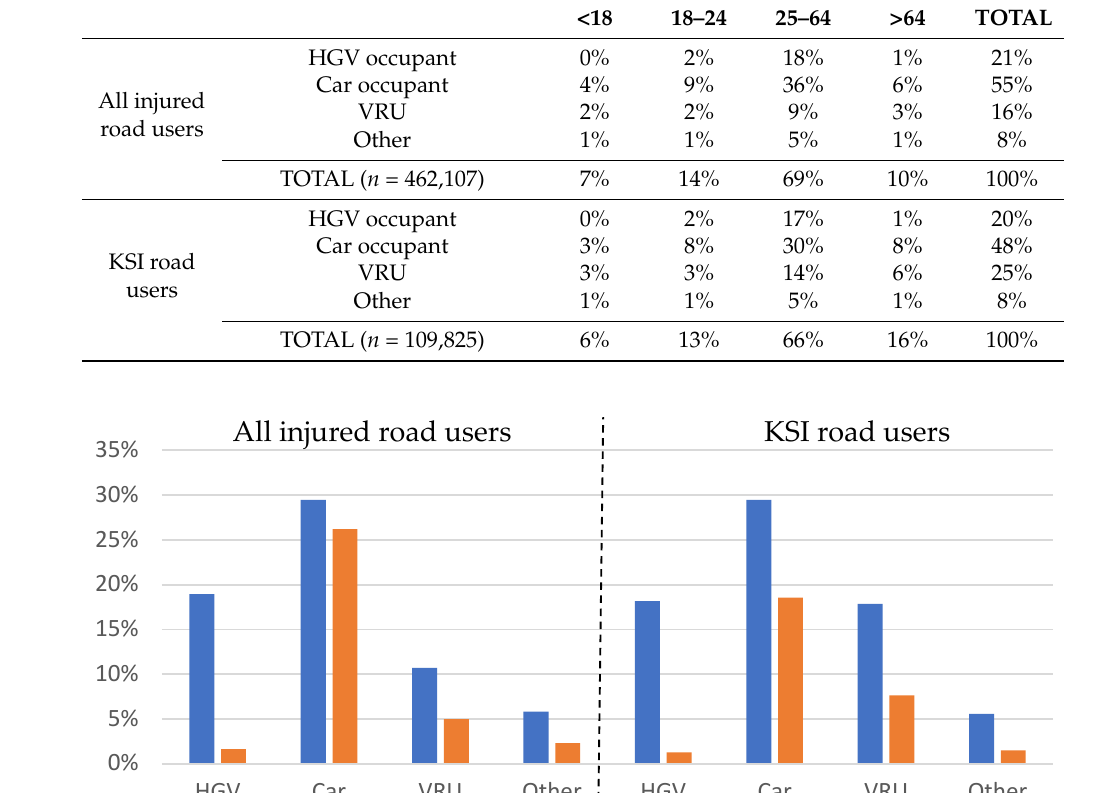
Table 1. Joint distribution of age and road user group for people injured in crashes with HGV involvement in EU-28, separately for all injury levels and killed or seriously injured (KSI), with rounded values, based on CARE data.